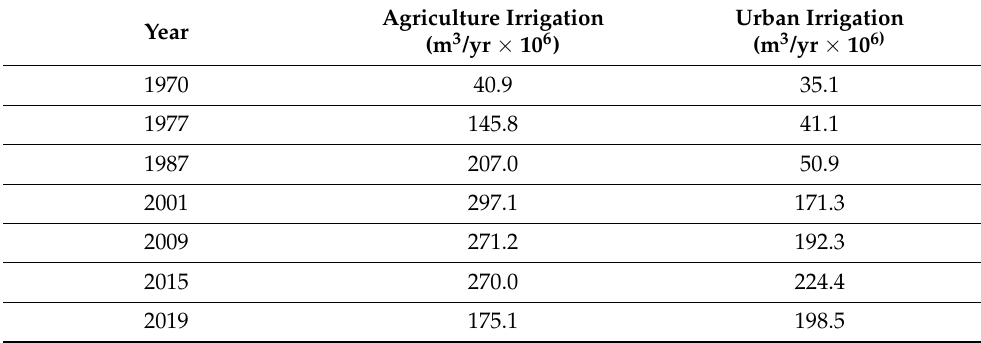
Table 1. Wastewater reuse for irrigation in California from 1970 To 2019 [12,13].